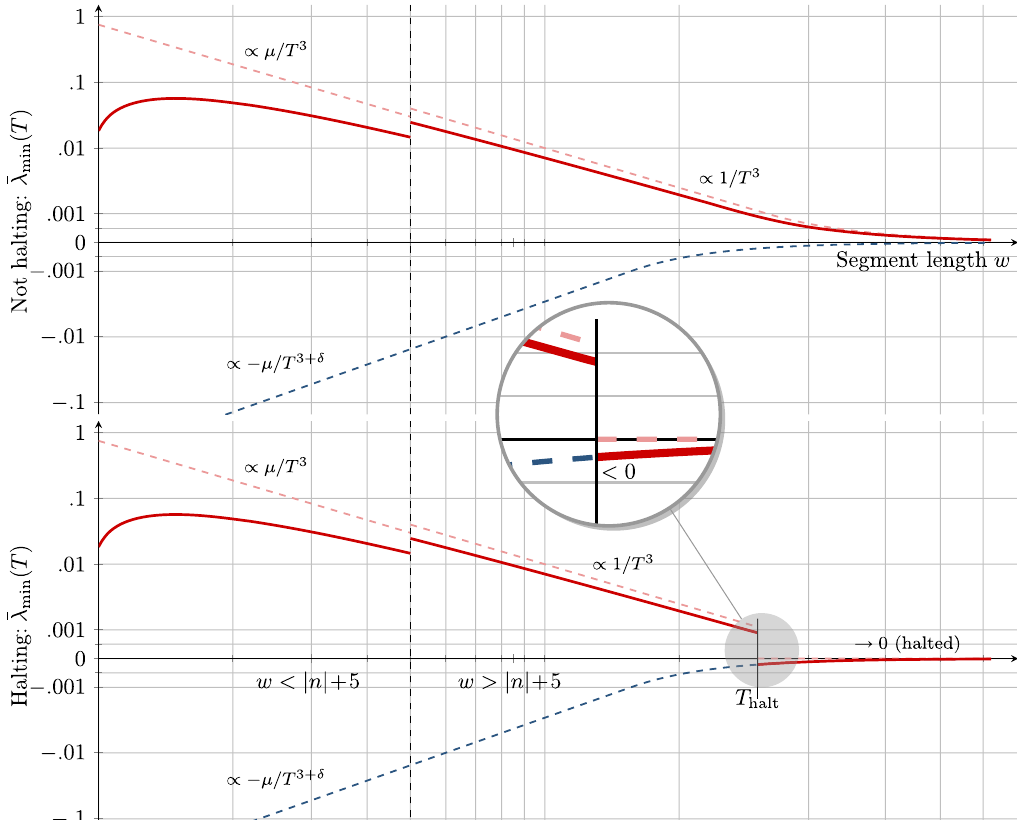
¯ λ T Þ from a single segment of length w of the marker and TM Hamiltonian μ H 0 þ H FIG. 3. Energy contribution shown in red, C min ð where T is the runtime of the encoded computation bounded either by the segment length or by the halting time of the TM. The prefactor μ ¼ 2 − 2 j η j is a small constant to compensate for the fact that on too-short segments the phase estimation truncates the output, which we ; i.e., the energy penalty inflicted in the case of can penalize only with strength Ω ð μ =T 3 Þ . The dashed red line is the contribution of H C the Turing machine running out of space. The dashed blue line is the bonus from μ H 0